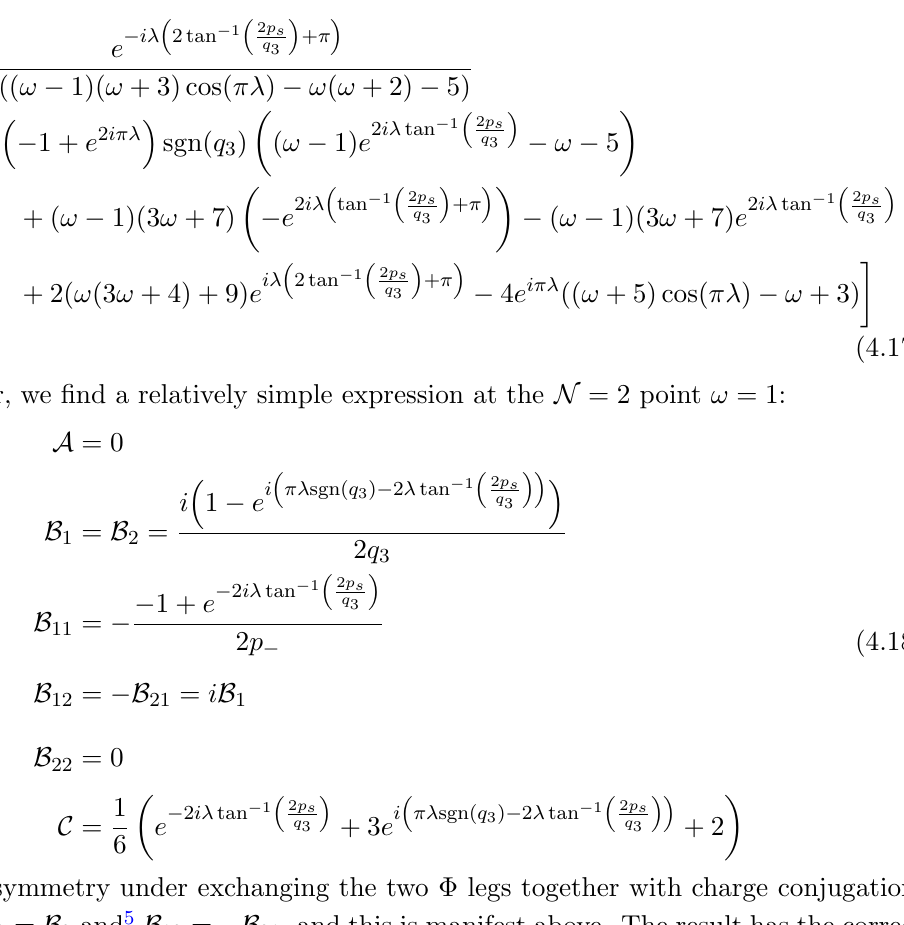
JJ (cid:31) (cid:30)